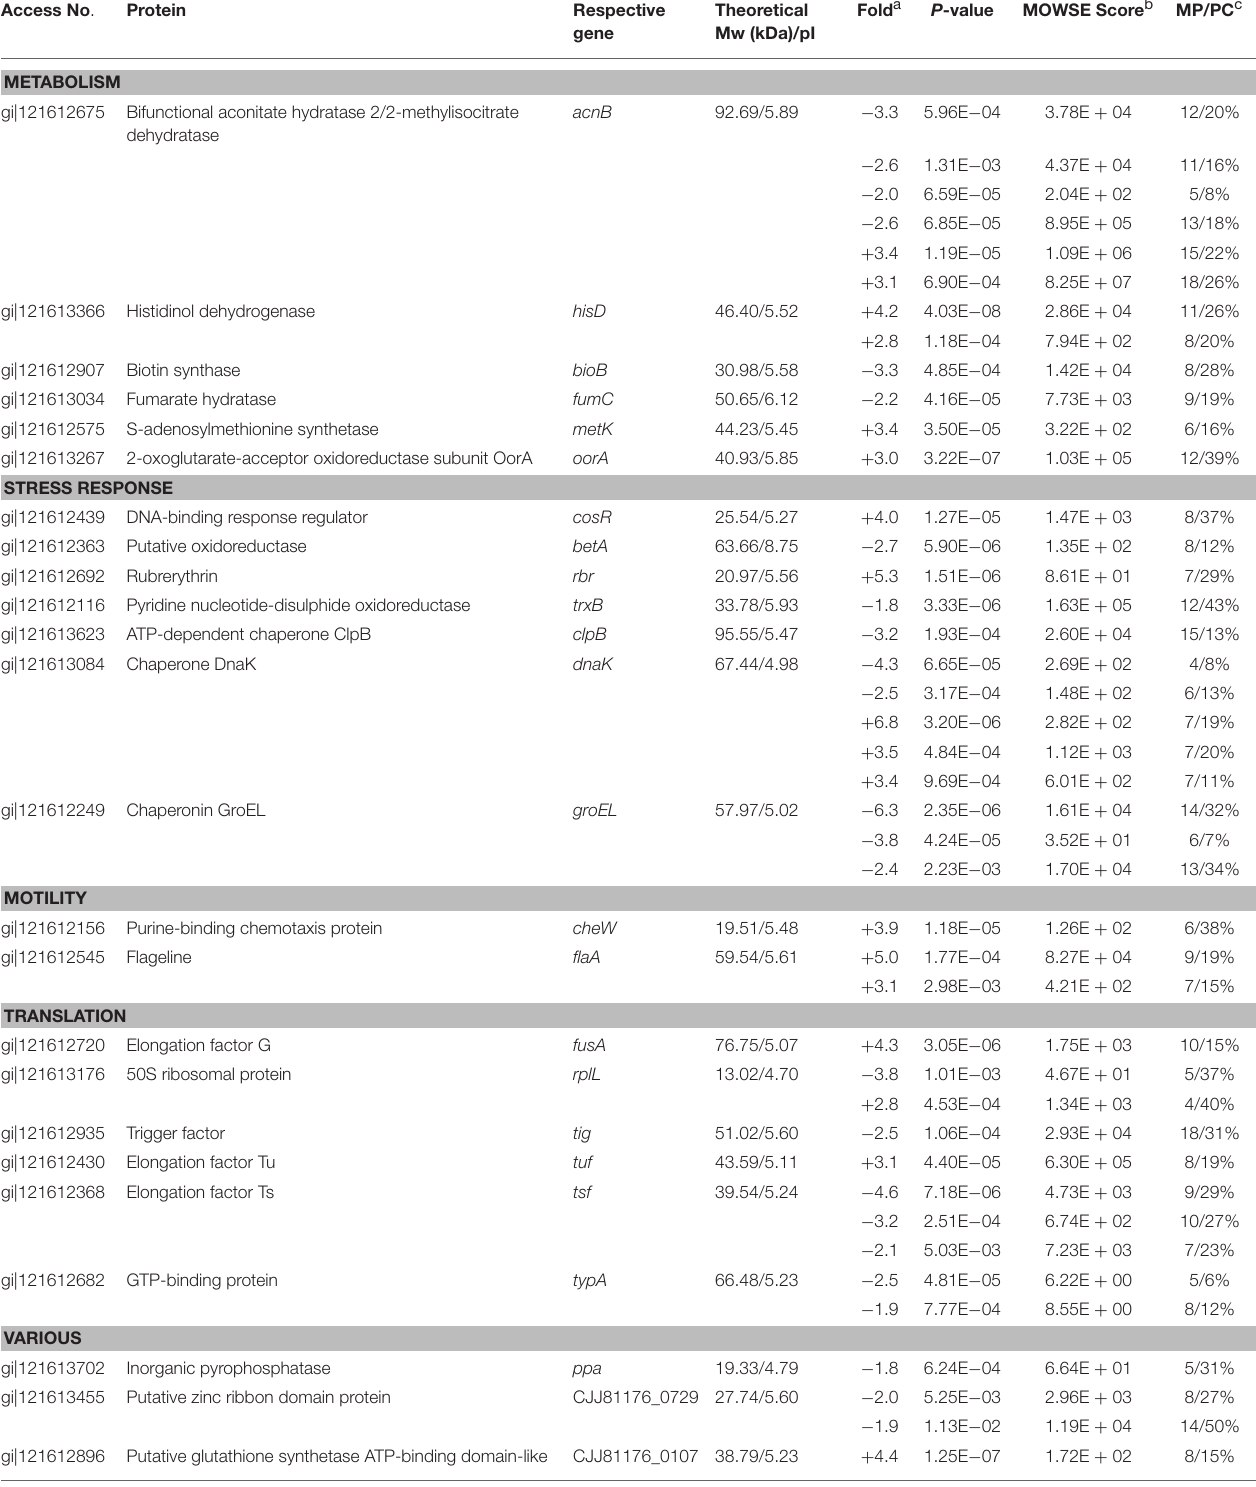
TABLE 2 | Identification of spots differently expressed in exponential phase (7 h) and early stationary phase (16 h) of C. jejuni growth. Access No